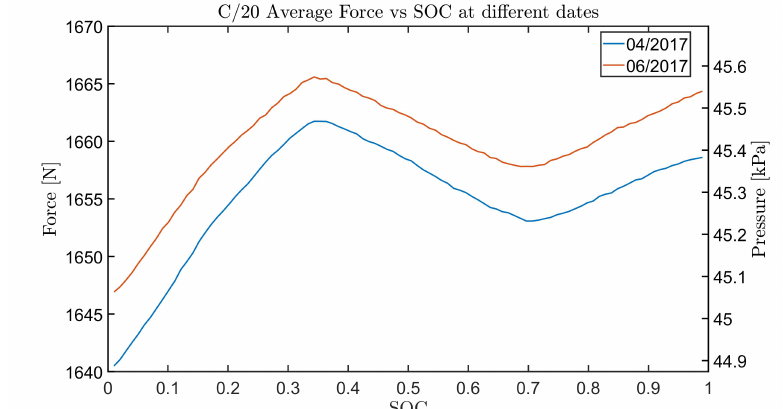
Figure 2. Drift in the force sensor can be observed by comparing the force vs. SOC for two C which were conducted two months apart with three cycles done in between them with the same battery. The force measurements have a minimum of 3 N and a maximum of 6 N drift across the entire SOC range. The drift could be caused by thermal expansion of the battery, pad, and fixture [13], capacity change, or a combination of all four throughout the life of the cell and module on which measurements are performed. Adjustments in the fixture and changes in the preload will cause larger changes in measured force but can also be modeled as a sensor drift. For generalization of the results to the other cell sizes, the pressure is